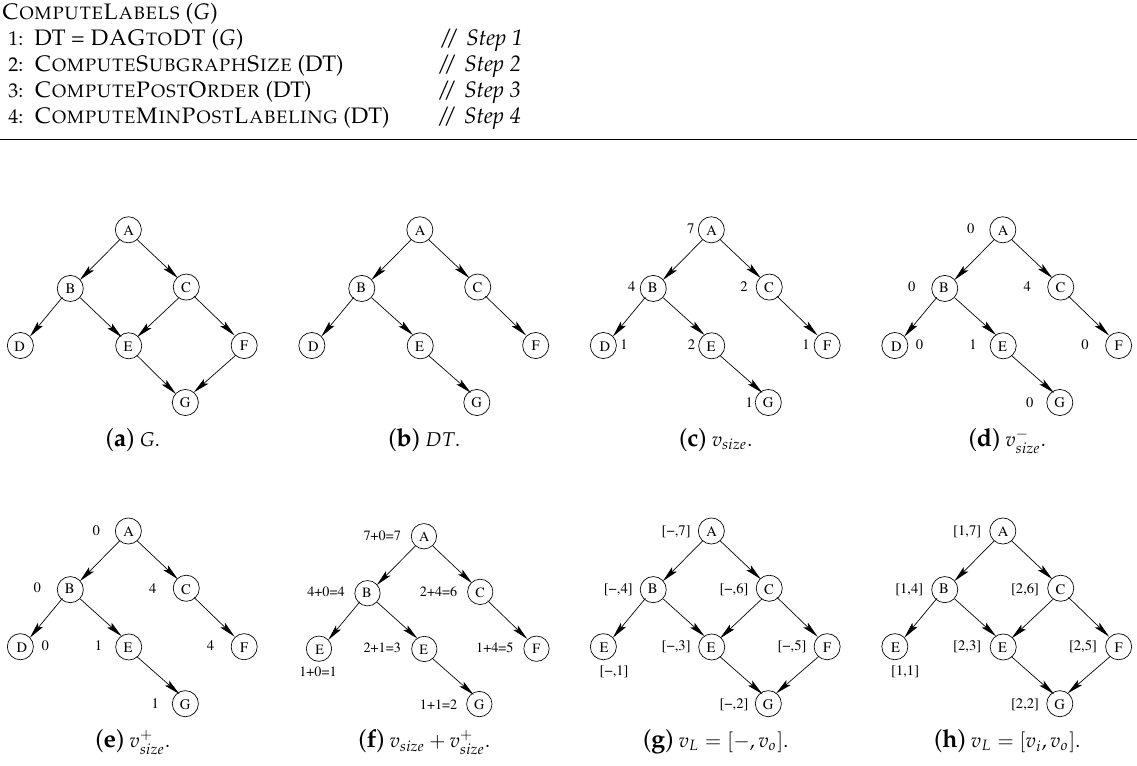
) , and the , v + , the value ( v size + v + size size size